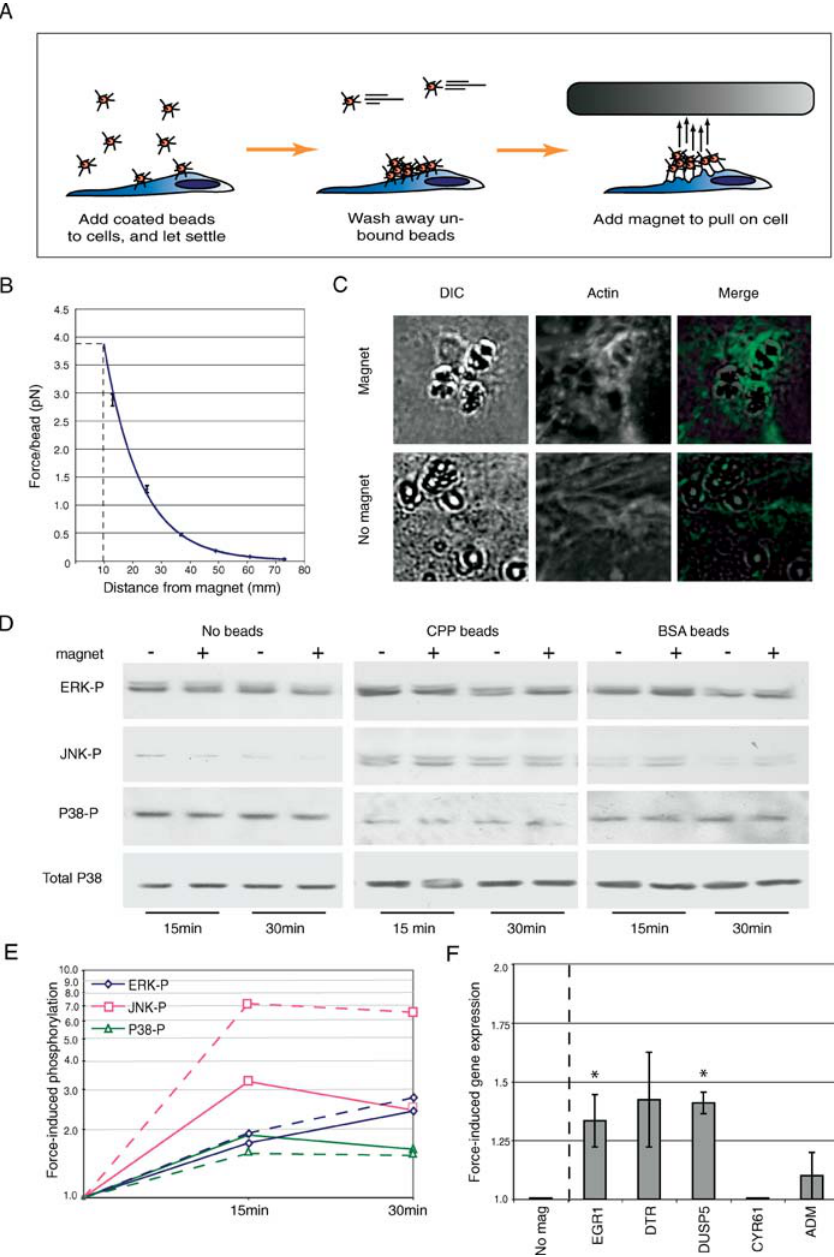
Figure 4. Artificial Force Triggers MAPK Phosphorylation and Induces the Expression of Retraction-Enhanced Genes (A) Representation of the magnet/magnetic bead assay. (B) Average force generated on one bead as a function of magnet distance from the culture dish. Data represent the forces calculated from four identical magnets ( 6 SEM). All subsequent assays were performed using a magnet distance of 10 mm, which corresponds to a force of 4 pN per bead (dotted line). (C) Magnet-induced clustering of actin beneath magnetic beads. CPP-coated beads were seeded onto T84 cells and exposed to the magnet for 1 h (top panels) or left untreated (no magnet, bottom panels). Differential interference contrast images (left panels) reveal the location of the beads; phalloidin staining (middle panels) shows the presence of actin at the same site. Right panels show the two previous images merged. (D) Representative immunoblot of ERK-p, JNK-p, and P38-p in cells seeded with CPP-coated beads, BSA-coated beads, or no beads, and exposed to the magnet for 15 or 30 min. Total P38 protein levels in each sample served as the internal control (bottom panels). (E) Quantitation of ERK-p, JNK-p, and P38-p signals by densitometry from the representative immunoblot shown in (D), normalized to the no- bead control. Solid lines indicate signals from cells exposed to membrane-coated beads; dotted lines indicate signals from cells exposed to BSA- coated beads. (F) Real-time quantitative RT-PCR analysis of the transcript levels of selected genes in cells seeded with CPP beads and exposed to the magnet for 3 h. Data represent the average fold-change ( 6 SEM, n = 2) compared to a no-magnet control. A significant difference in expression on force induction is denoted by an asterisk ( p , 0.1). DOI: 10.1371/journal.pbio.0030100.g004